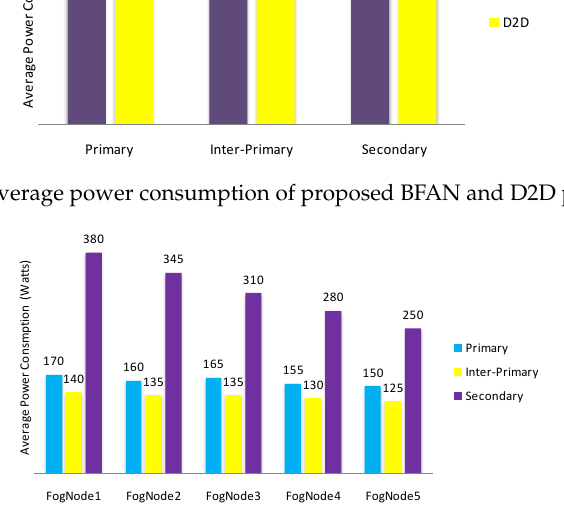
Figure 7. Average power consumption of primary, interprimary and secondary communication.